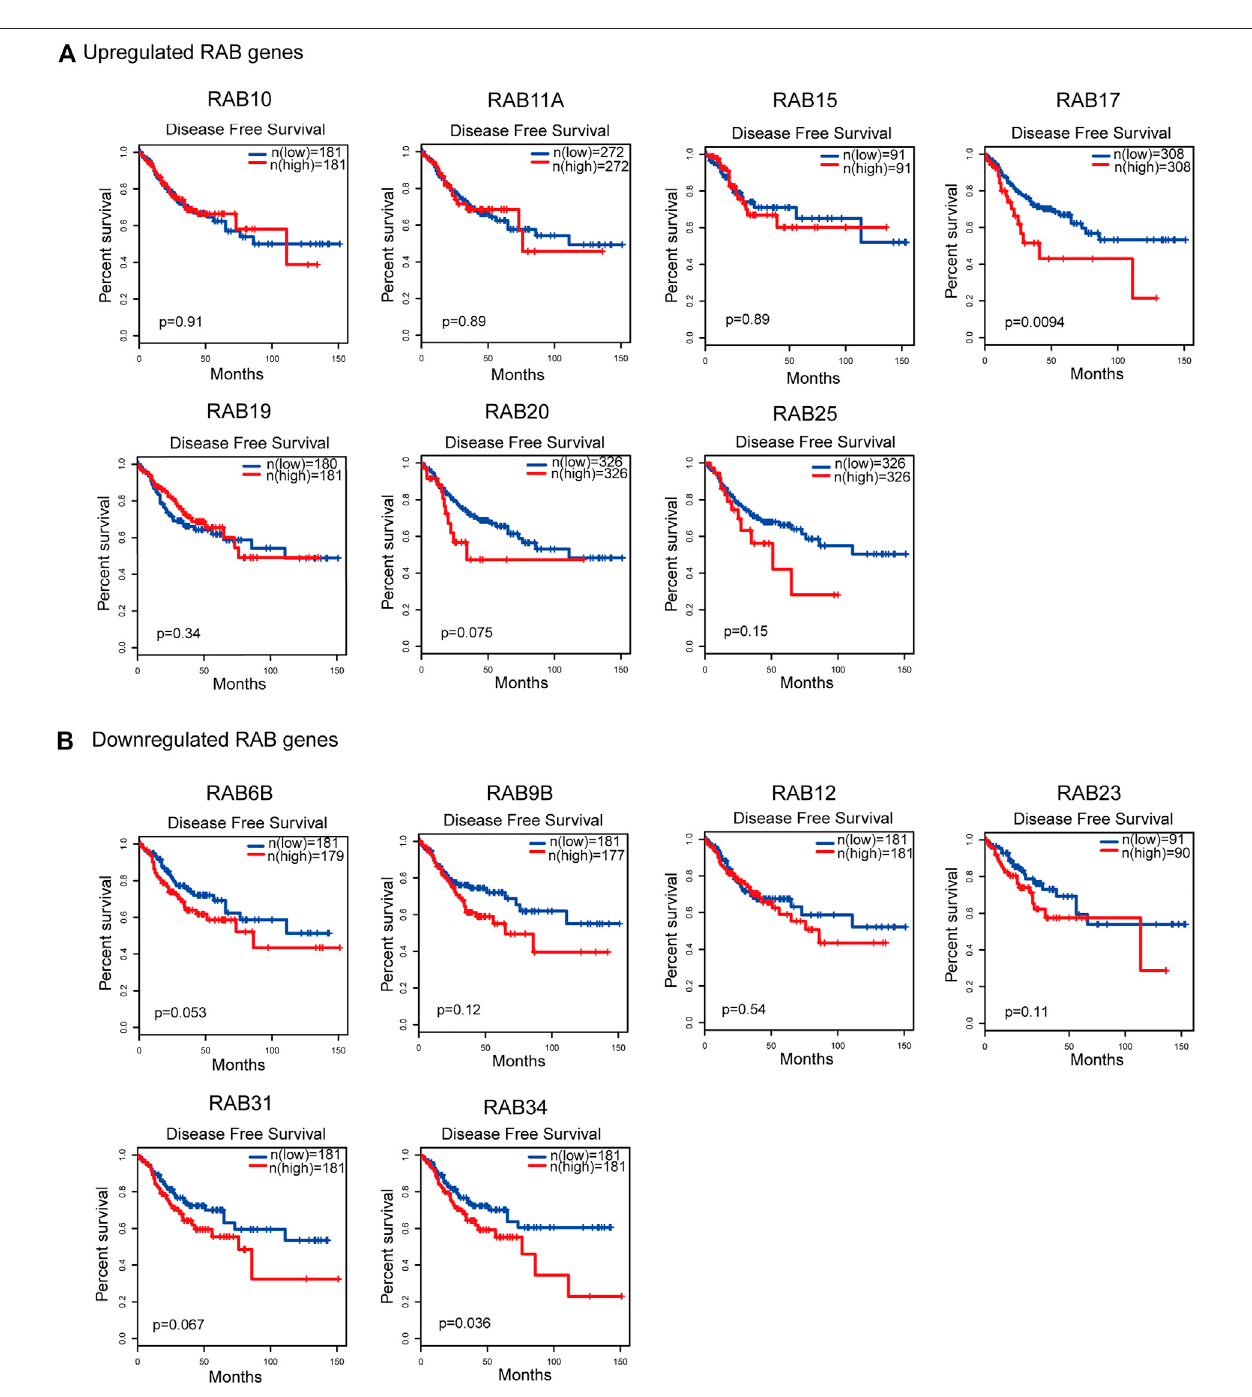
FIGURE6| Kaplan – Meierplotsforthedisease-freesurvivalofCRCpatientsstrati fi edbythemRNAexpressionlevelofRABs. (A) Thedisease-freesurvivalcurvesof the upregulated-RABs (RAB10, RAB11A, RAB15, RAB17, RAB19, RAB20, and RAB25). (B) The disease-free survival curves of the downregulated-RABs (RAB6B, RAB9B, RAB12, RAB23, RAB31, and RAB34).